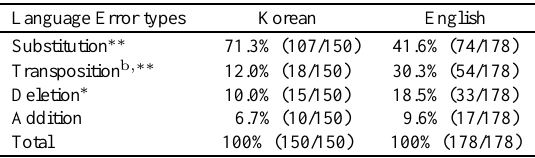
Table 2 Error rates (%) according to types of errors (Number of errors/Total number of errors) in Korean and English letter writings a Language Error